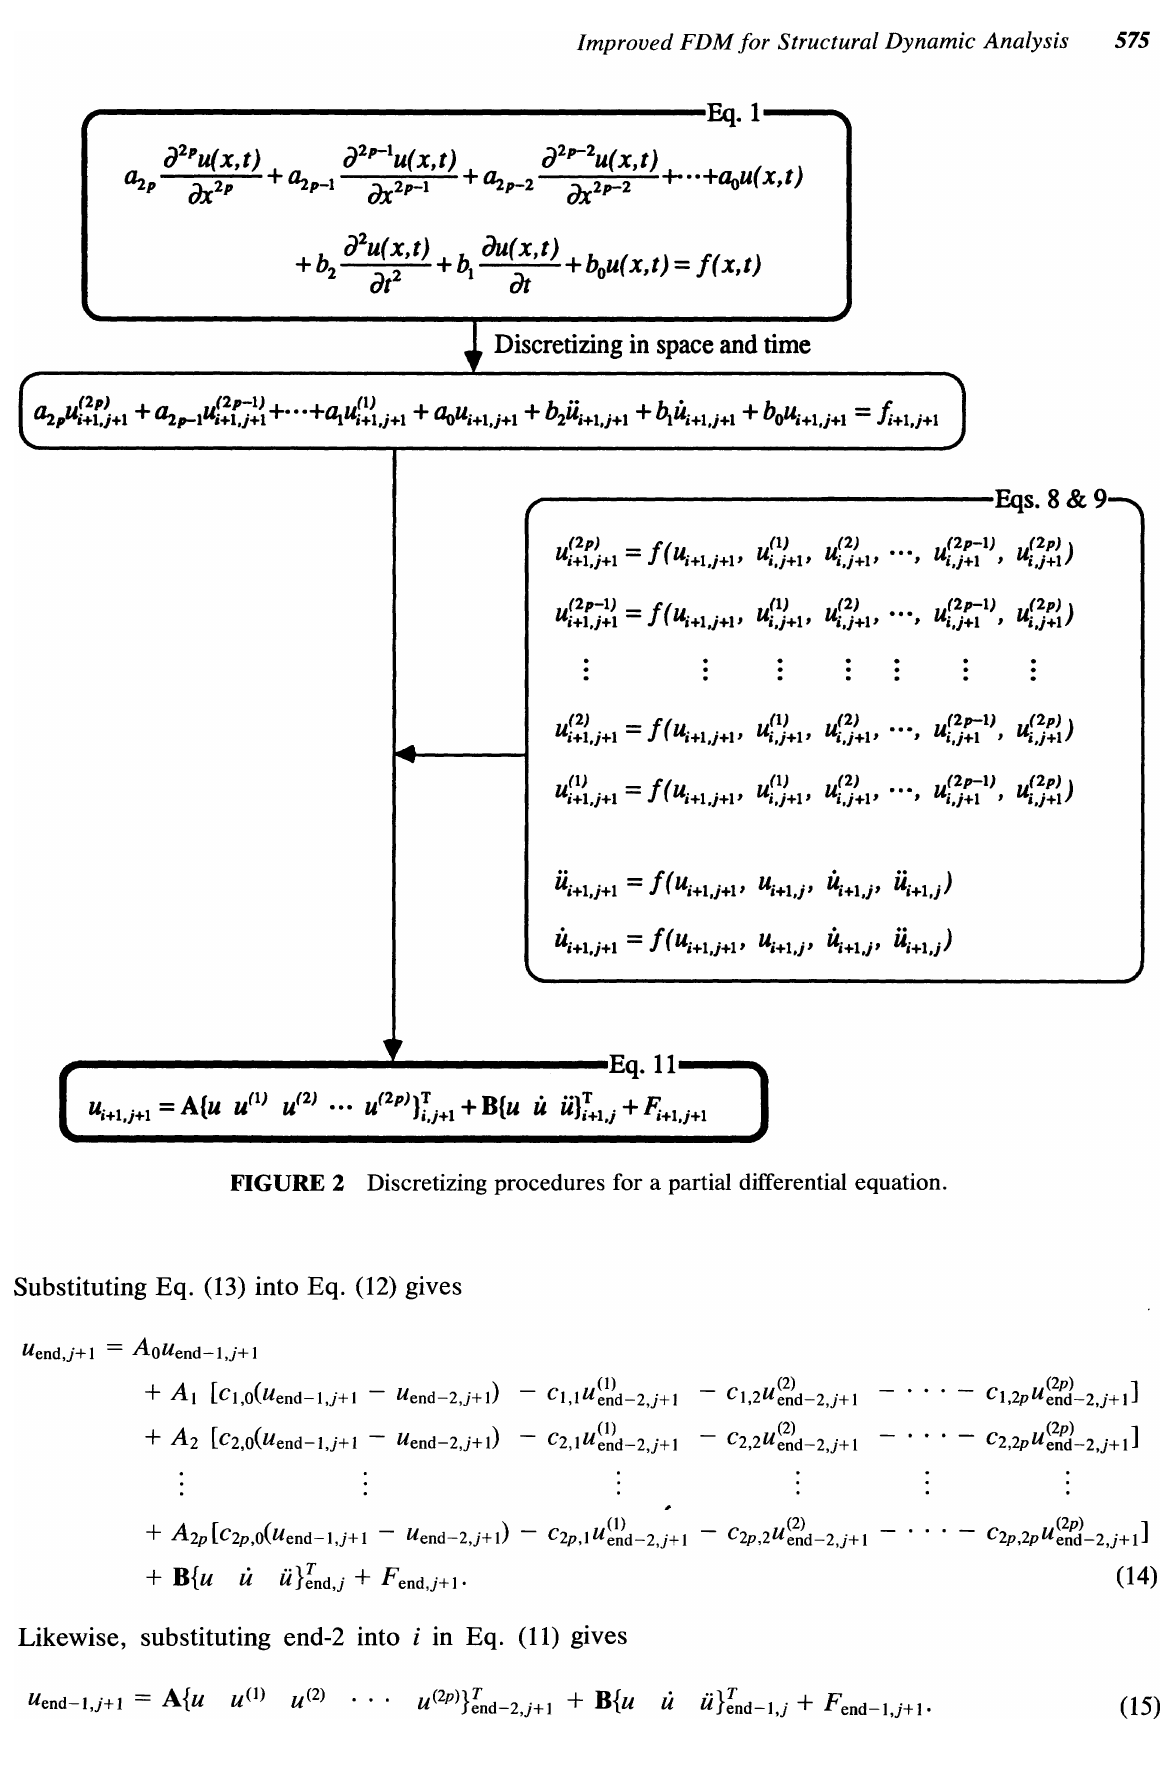
FIGURE 2 Discretizing procedures for a partial differential